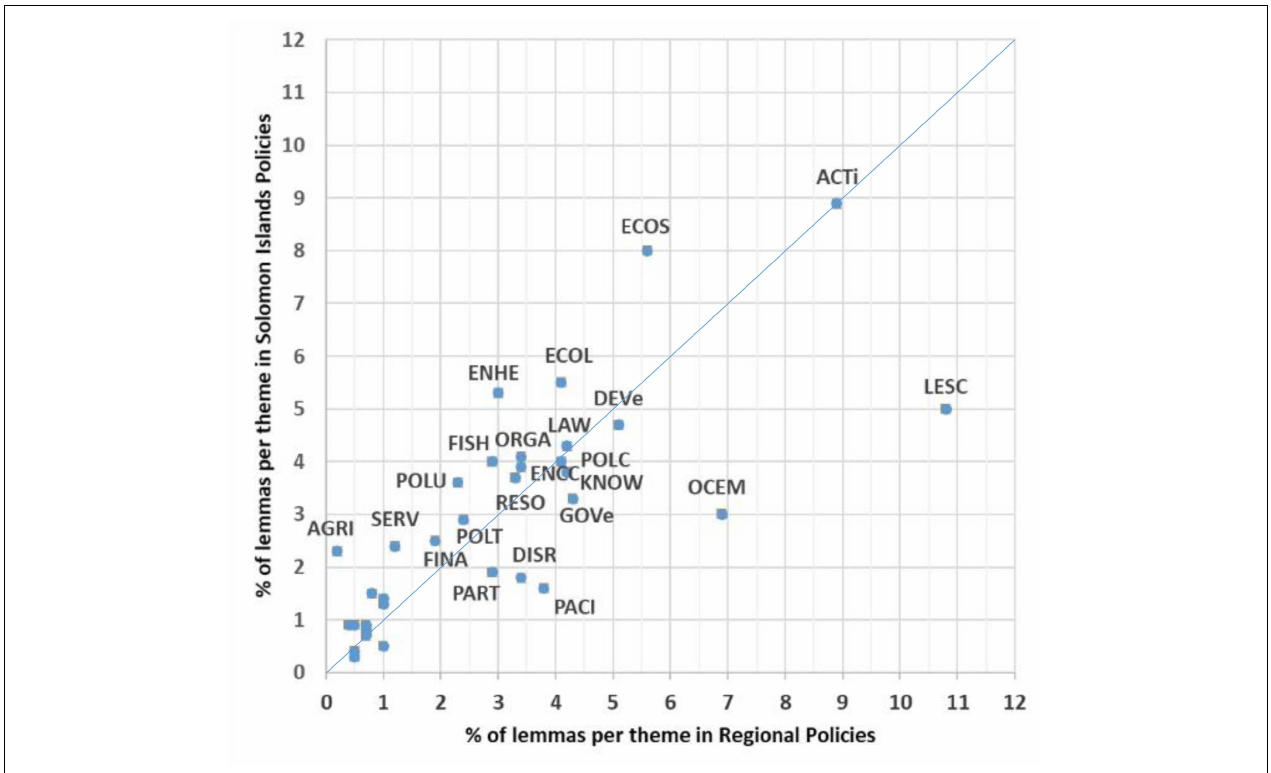
FIGURE 9 | Percentage of lemmas dedicated to each theme in regional policies (x-axis) and Solomon Islands policies (y-axis). Equal percentage of lemmas about the same theme in regional and national policies align to the diagonal line or parity. The themes above the diagonal are more developed in Solomon Island policies, whereas those below are more developed in regional policies. Labels of themes below 2% limit on both axes are not given for the readability of the figure (i.e.) CAPA, ENER, SECU, TRAN, CUVA, EDUC, GEVU, NUFO, COMU, COMI,